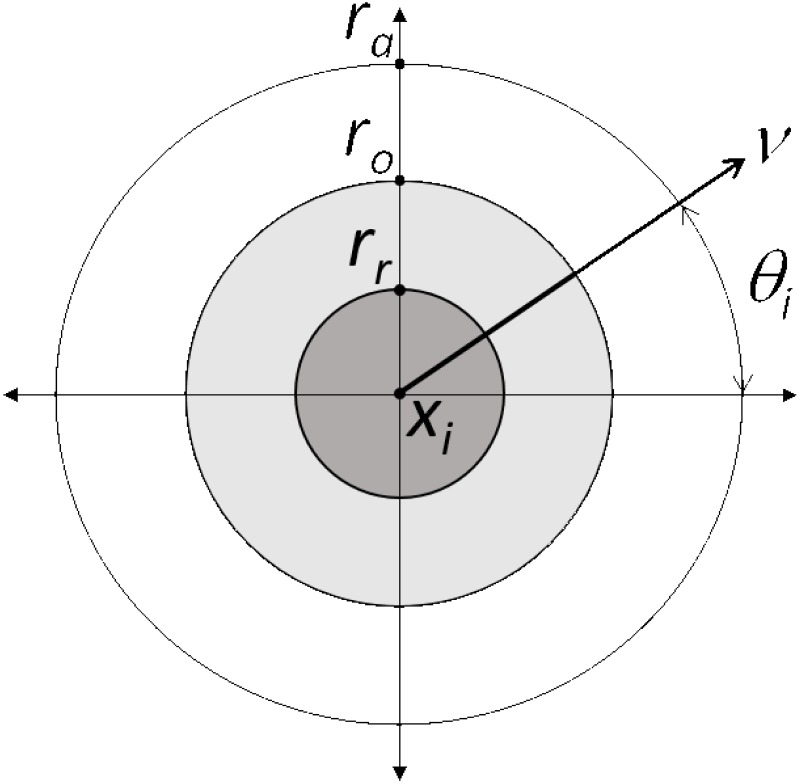
Simulation model zones.Zones of repulsion, orientation and attraction for an animal within a two dimensions Couzin model. The individual is at position xi travelling in direction θi at speed v. The zone of repulsion is the region (in dark grey) of points within rr, the zone of orientation is the region (in light grey) of points between rr and ro of xi and the zone of attraction is points between ro and ra of xi.